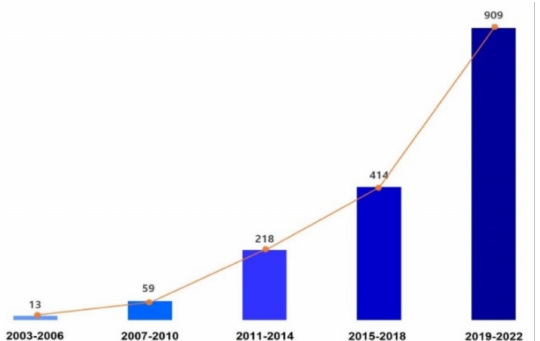
Figure 2. Number of published Paralympic studies in 2003–2022 (section from one year before the Paralympic Games to every two years after the Paralympic Games).